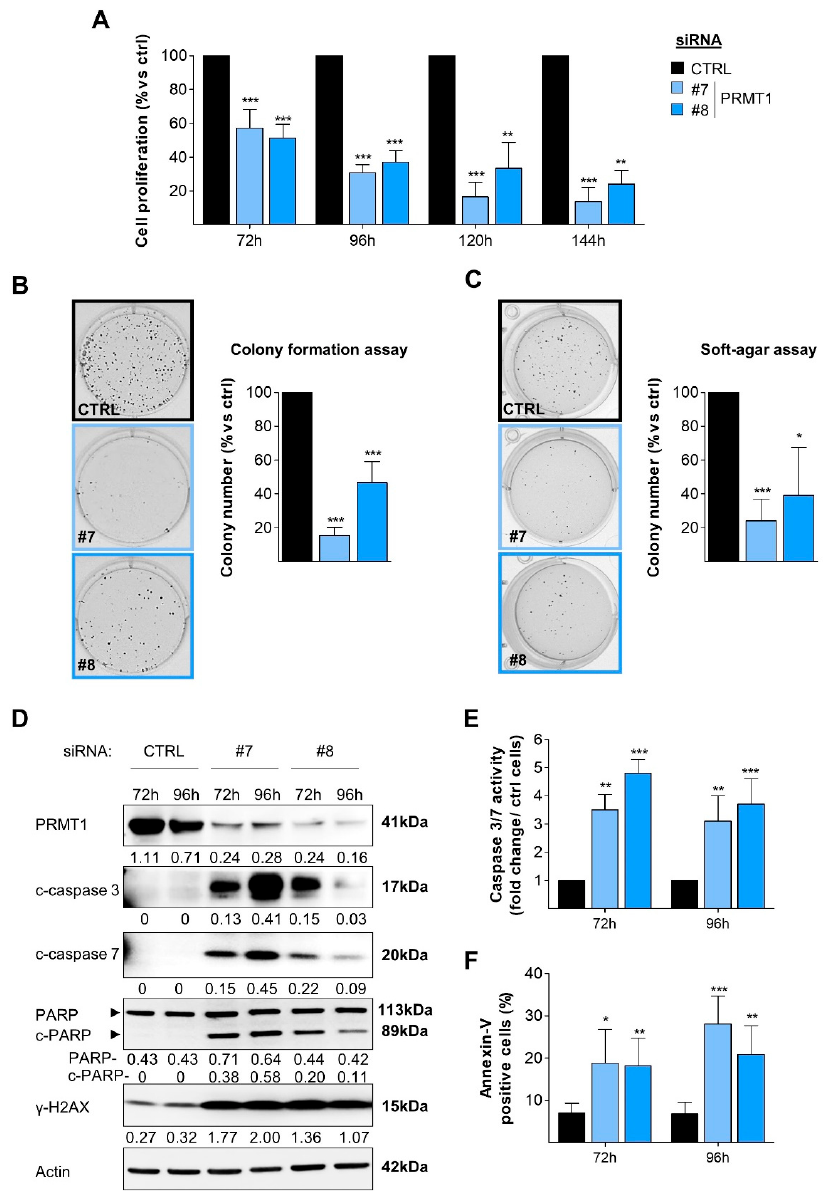
Figure 2. PRMT1 depletion decreases cell viability and induces apoptosis of MDA-MB-468 cells. ( A ) PRMT1 depletion impairs cell viability (MTT assay). Cells were transfected with control (CTRL, black) or two different PRMT1 siRNAs (#7, #8, blue) for 72–144 h. ( B , C ) PRMT1 depletion impairs colony formation when cells are grown on plastic for 13 days ( B ) or in soft agar for 4 weeks ( C ) following siRNA treatment. ( D – F ) PRMT1 depletion induces apoptosis. Apoptosis was detected by Western blotting using antibodies recognizing the cleaved forms of caspase 7 (c-caspase 7), caspase 3 (c-caspase 3) and PARP (c-PARP) ( D ), by caspase 3/7 assay ( E ) or annexin-V staining ( F ) after 72 h and 96 h following siRNA treatment. DNA damage was detected using an anti- γ H2AX antibody ( D ). PRMT1 depletion was verified using an anti-PRMT1 antibody ( D ). Anti-actin antibody was used as a loading control and quantification of the bands (normalized to the loading control) are indicated below each blot ( D ). Results are presented as the percentage ( A – C , F ) or fold change ( E ) relative to control cells (CTRL). For the quantifications, the data are expressed as the mean ± SD from at least three independent experiments ( A – C , E , F ). Pictures are from a single experiment, representative of three independent experiments ( B – D ). p -values are calculated from a Student t -test and represented as * p < 0.05; ** p < 0.01; *** p < 0.001 ( D